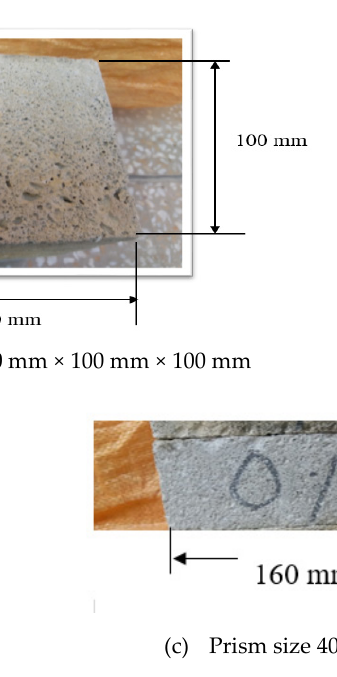
Figure 4. Dimension of specimens tested during this study. ( a ) dimension of cube specimen ( b ) dimension of cylindrical specimen ( c ) dimension of prism specimen.